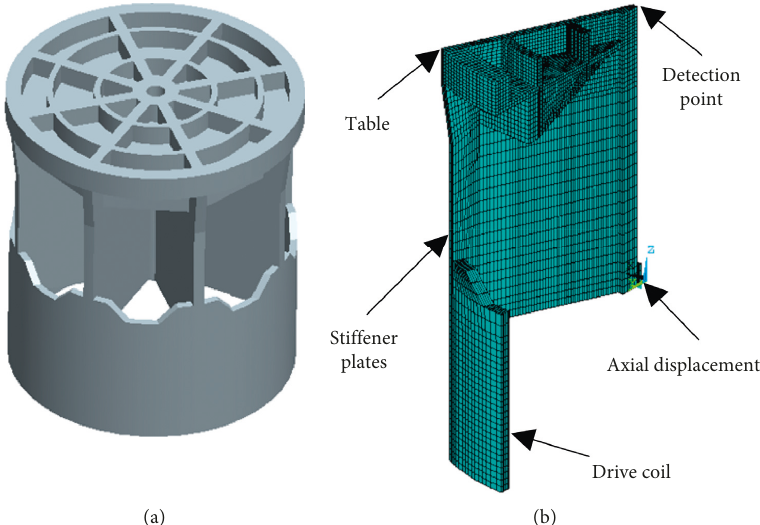
Figure 2: The moving coil of electrical-dynamic shakers. (a) The entire geometric model. (b) The simplified FE model.